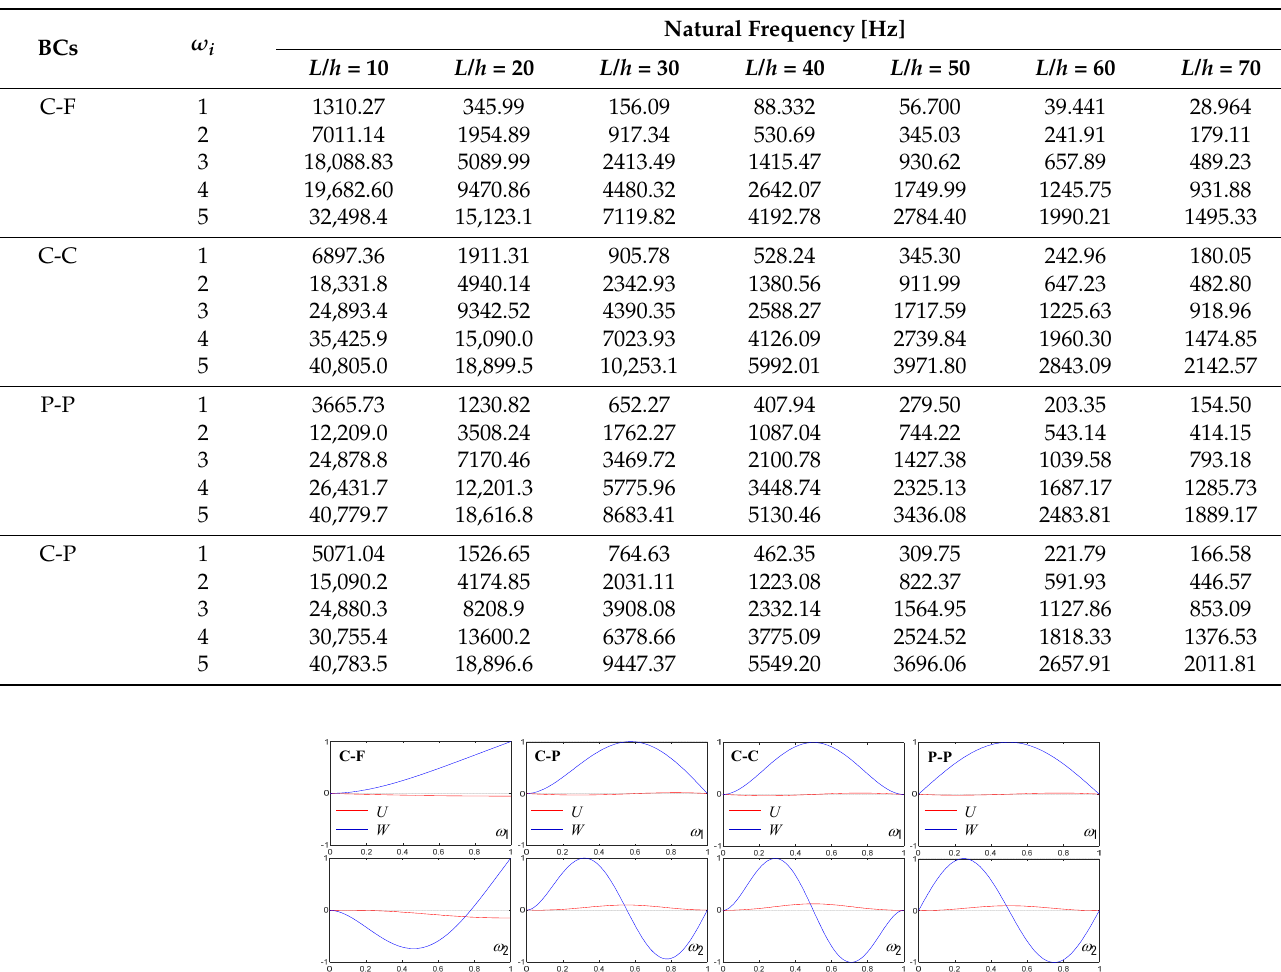
Table 3. Effects of the variation of L/h on the first five natural frequencies of the symmetric three- layered beam with the classical boundary conditions.